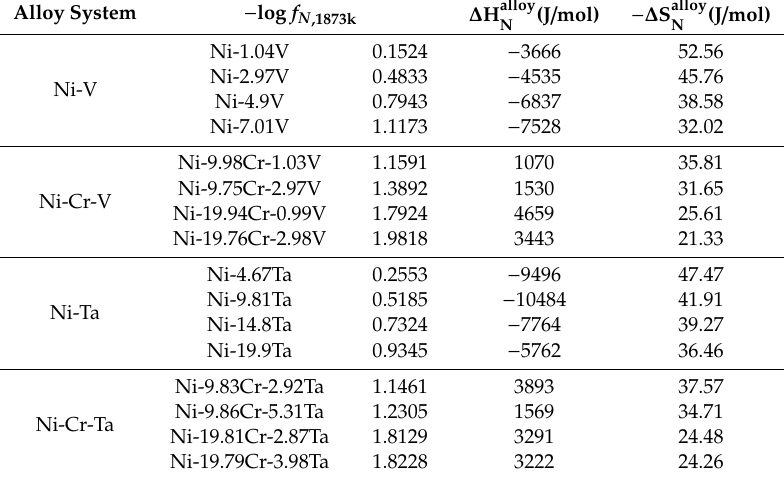
Table 5. Experimental results, enthalpy and entropy of dissolution of nitrogen and logarithm of activity coe ffi cient of nitrogen at 1873